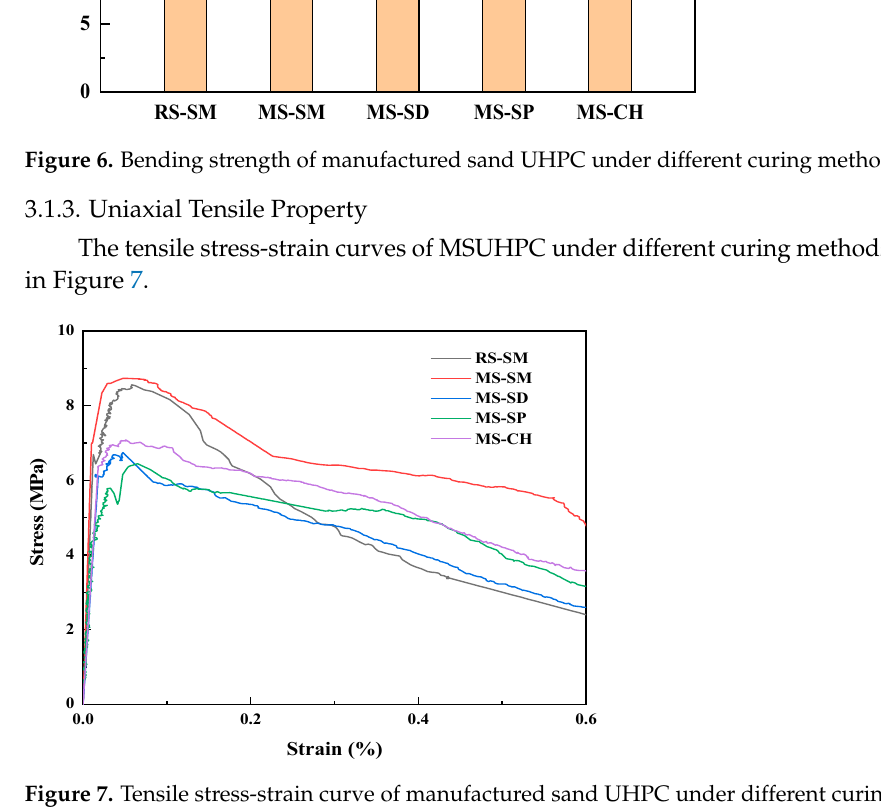
Figure 7. Tensile stress ‐ strain curve of manufactured sand UHPC under different curing methods.